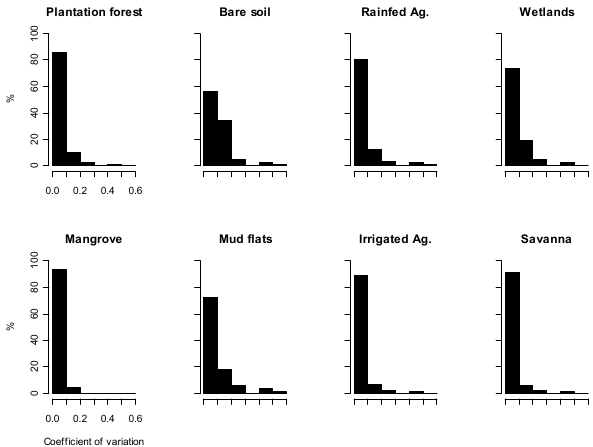
Figure 7 Mean GEMS modeled soil organic carbon (SOC) computed for the entire study area under the no climate change scenario , from 1900 to 2052 at 4 yearly intervals, using the 9 land cover land uses classes and different Landsat classification approaches. The open circles show the mean SOC for each of the 30 independent bagged decision trees Fig. 6. Histograms of the year 2000 SOC coefficient of variation computed using the soft classification-carbon assignment approach; the orange filled circles show the mean across 30 soft classification simulations; the green filled circles (Fig. 5) for each land cover land use class defined by the hard clas- show the mean SOC derived simulations using the hard decision tree classification. sification (Fig. 1).